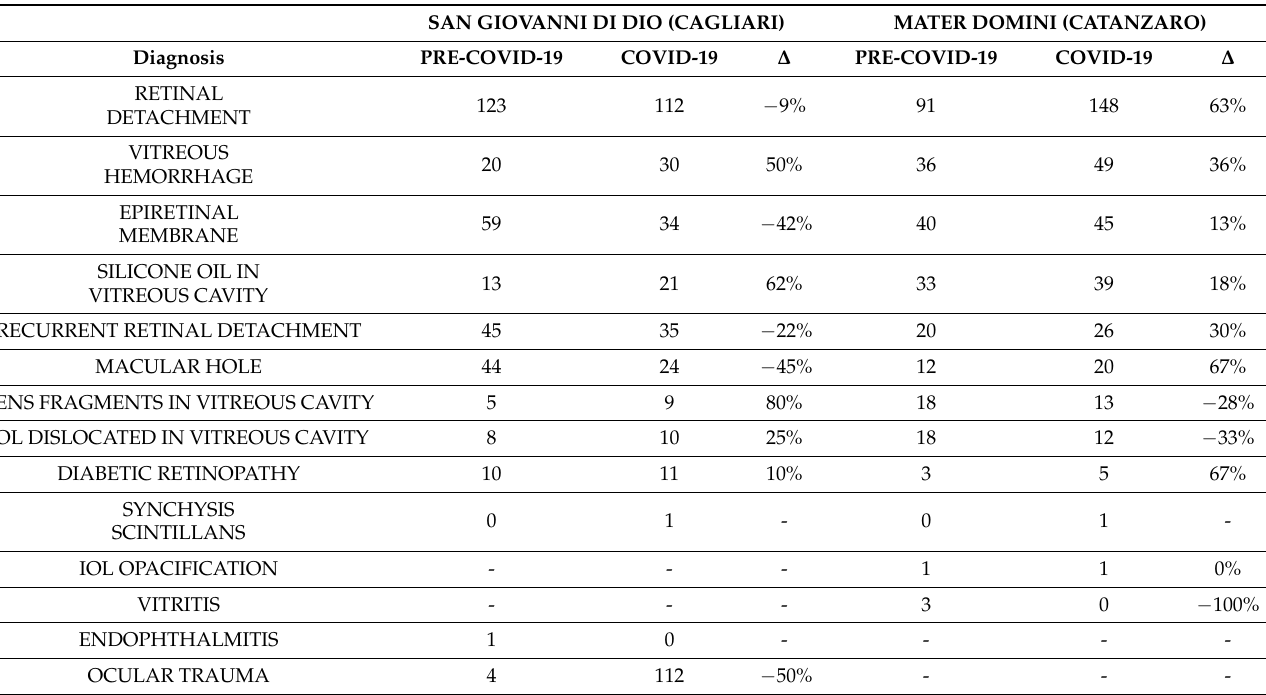
Table 5. Comparison of different diagnoses of surgically treated posterior segment diseases at San Giovanni di Dio (SGD), University of Cagliari, and Mater Domini, University Magna Græcia of Catanzaro